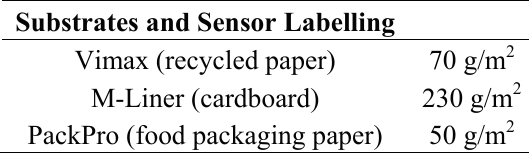
Table 2. Substrate grammage.